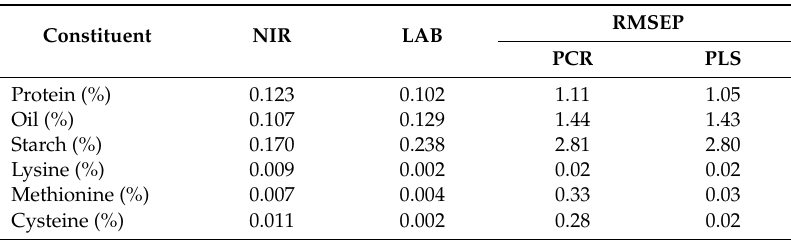
Table 3. Standard errors of near-infrared reflectance (NIR) predicted values and reference analysis of various grain constituents obtained from blue maize grain samples. Root mean squares of calibration set (RMSEP) calculated for principal component regression (PCR) and partial least square (PLS) calibration